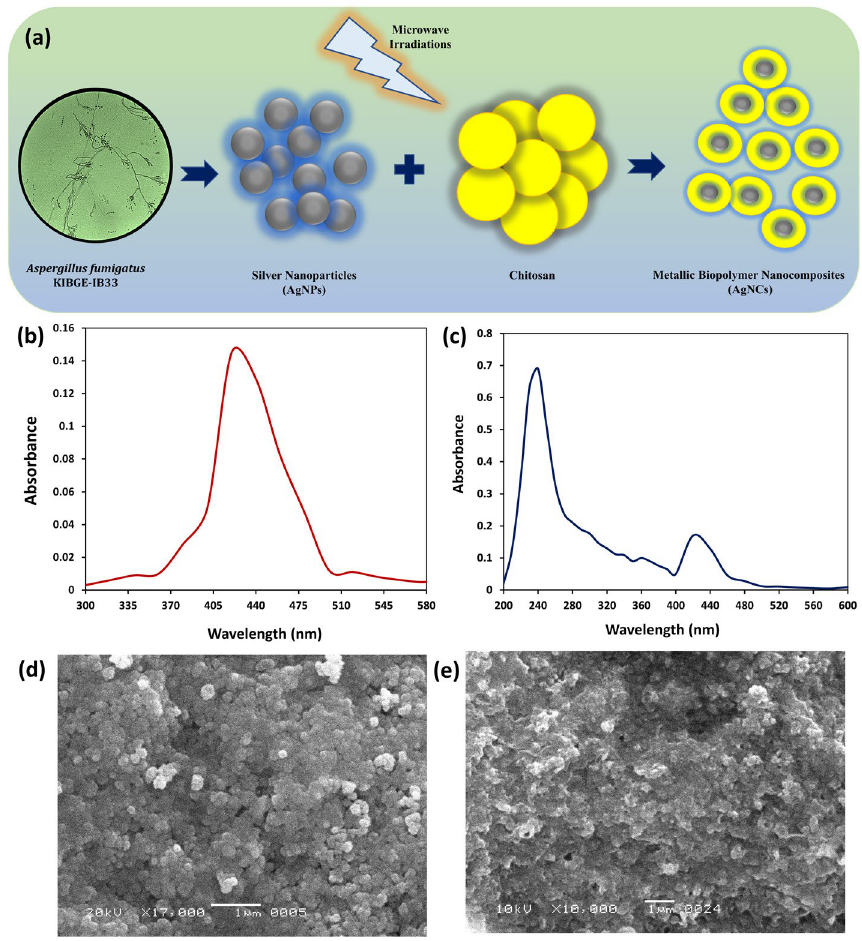
Figure 2. Fabrication and initial characterization of nanomaterials. ( a ) Schematic illustration of biosynthesis of silver nanoparticles (AgNPs) and fabrication of nanocomposite system (AgCNCs). ( b , c ) UV–visible spectra of AgNPs and AgCNCs, respectively. ( d , e ) surface topological analysis of AgNPs and AgCNCs, respectively using scanning electron microscope.